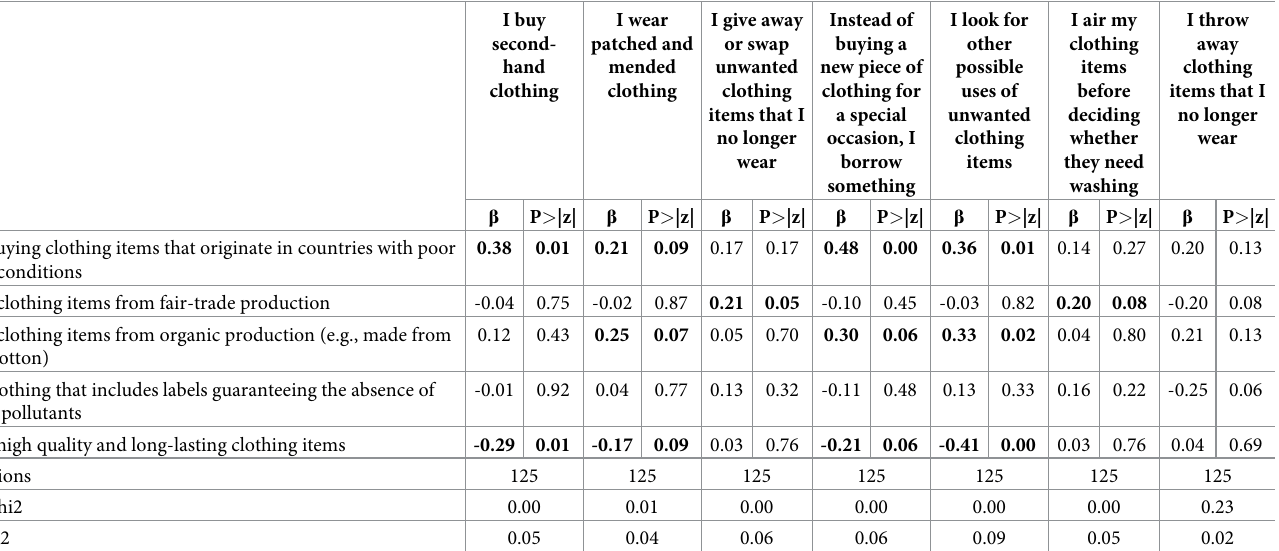
"instead of buying a new piece of clothing for a special occasion, I borrow something" ( β = 0.48, P > |z| = 0.00) and "I look for other possible uses of unwanted clothing items" ( β = 0.36, P > |z| = 0.01). Additionally, as in the case of men, negative and significant regression coeffi- "I select garments of high quality in their materials and elaboration, and with long duration", specifically, in the regressions with dependent variables "I buy second-hand clothing" ( β = Table 6. Logistic regression of older